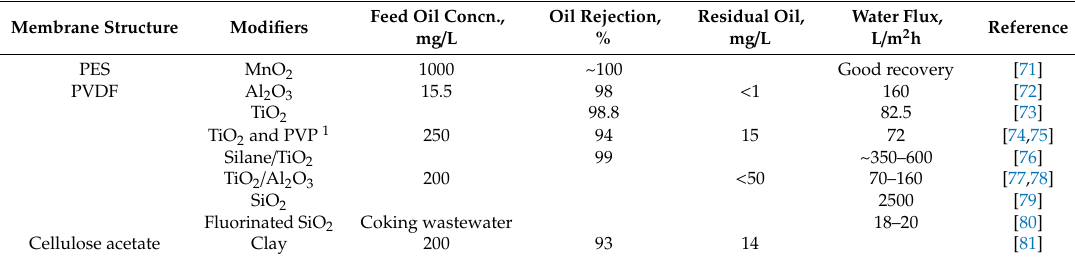
Table 3. Oil Removal results using organic / inorganic hybrid